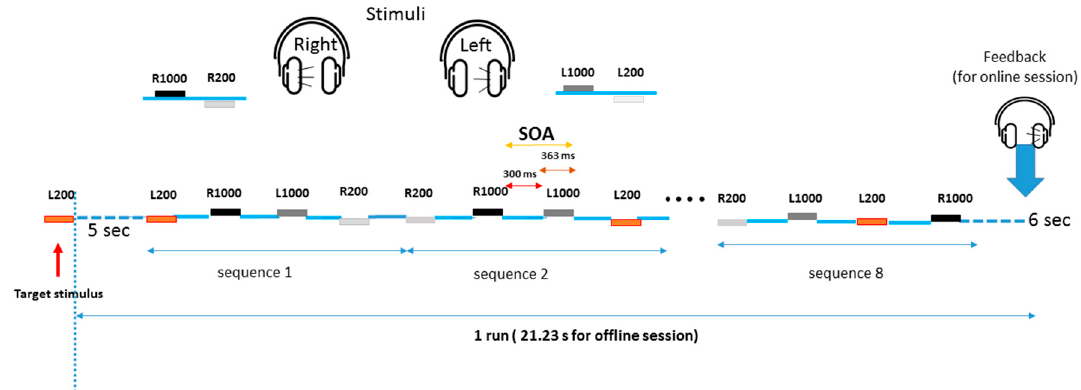
Figure 1. Trial time of a run. The number of sequences was 8 for the offline sessions and variable for the online sessions. The stimuli are R1000 (1000 Hz right), R200 (200 Hz right), L1000 (1000 Hz left), and L200 (200 Hz left). In this illustration, the target stimulus is presented in brown (200 Hz Left in this example). The feedback was only provided in the online sessions.